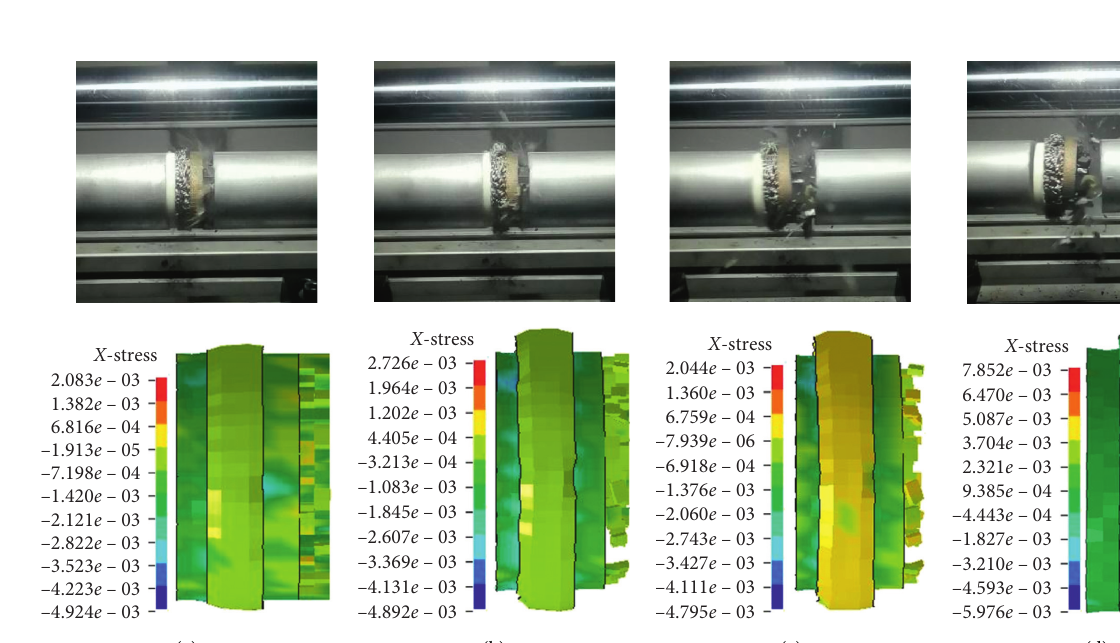
Figure 7: Structure III SiC/UHMWPE/MR/TC4.